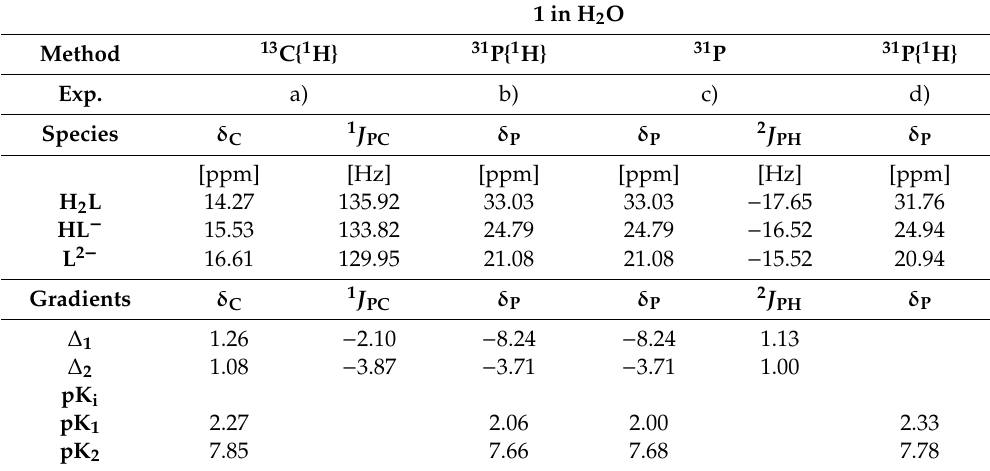
Table 2. Specific chemical shifts δ C , δ P and coupling constants 1 J PC and 2 J PH of methanephosphonic acid 1 were obtained by 13 C{ 1 H}-, 31 P{ 1 H}-, and 31 P-NMR-controlled titrations in H 2 O. ∆ i = δ (H n-i L)